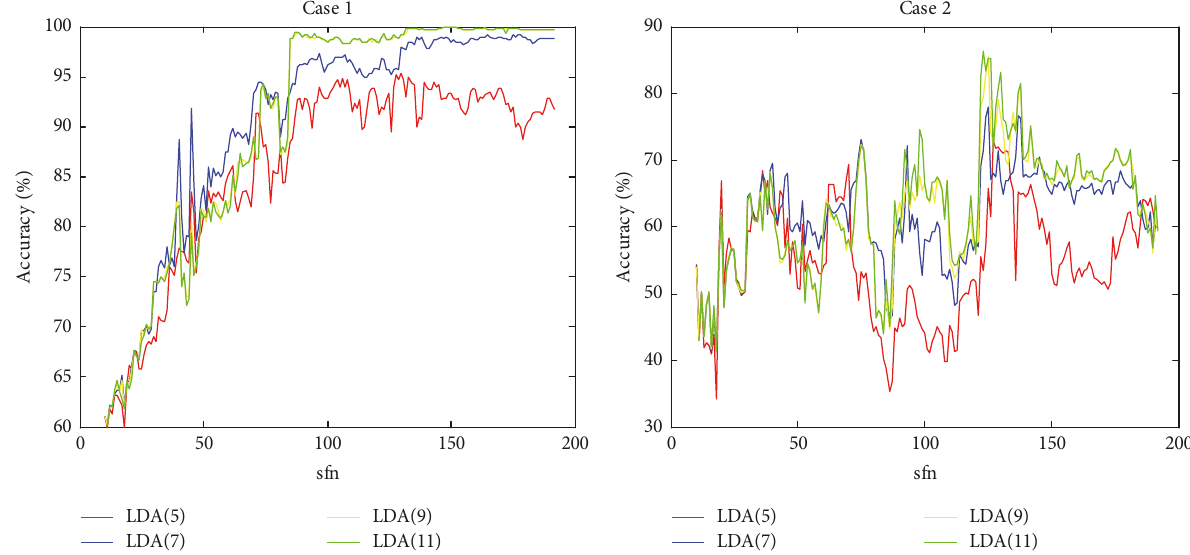
Figure 32: The diagnosis results obtained by OFS-FSASD-LDA-SVM with different number of dimension sizes for LDA. The LDA (5) represents that the number of dimension sizes is 5.